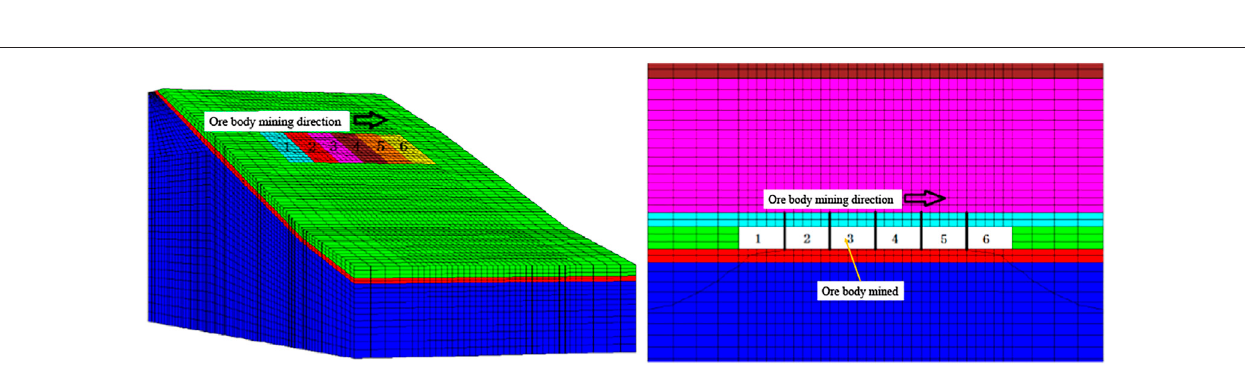
FIGURE 5 | Orebody mining by the caving